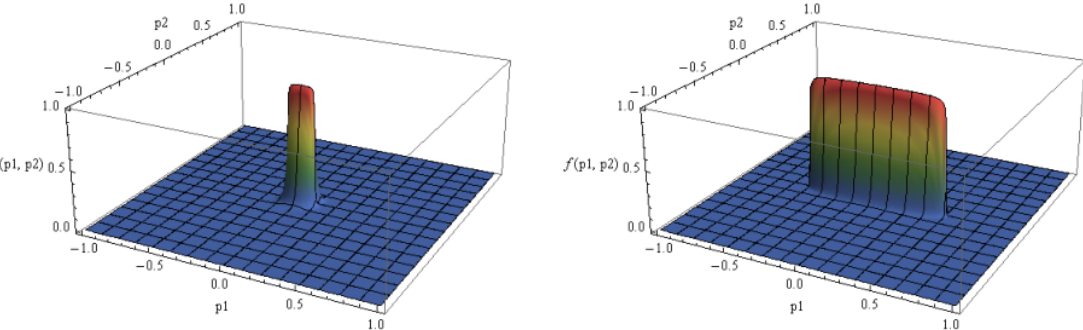
Figure 4. The distribution function in the planar momentum space after the action of the Eckart-Sauter pulse (58). Left panel : E a = 0.01 E 0 ( 1.088 × 10 8 V/m) and T = 10 t 0 ( 2.46 × 10 − 15 s), Right panel : E a = 0.01 E 0 ( 1.088 × 10 8 V/m) and T = 50 t 0 ( 1.23 × 10 − 14